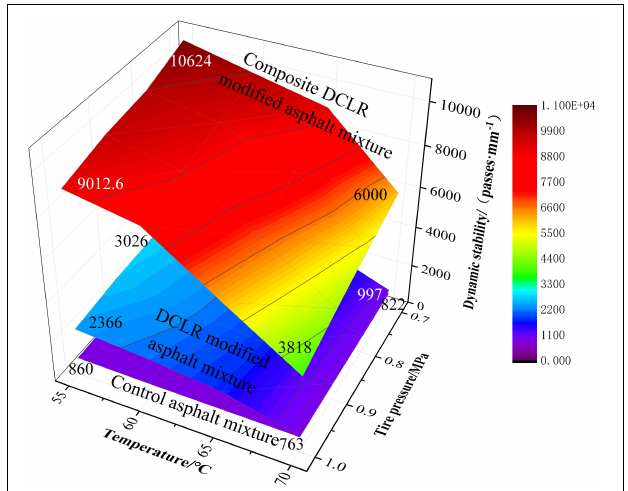
FIGURE 6 | Dynamic stability of three asphalt mixtures versus tire pressure and temperature.